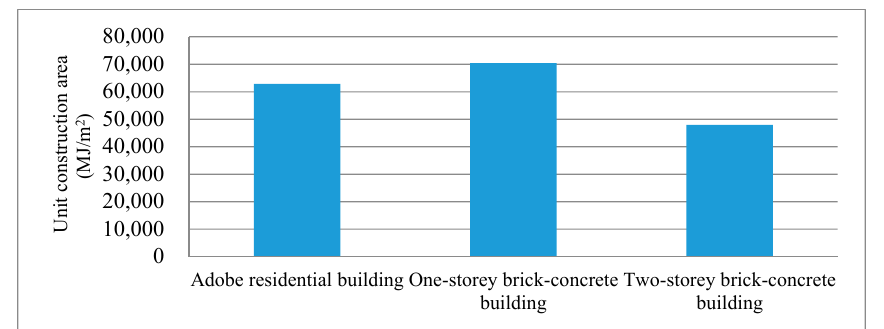
Figure 17. Total energy demand of the unit construction area in the full life cycle.